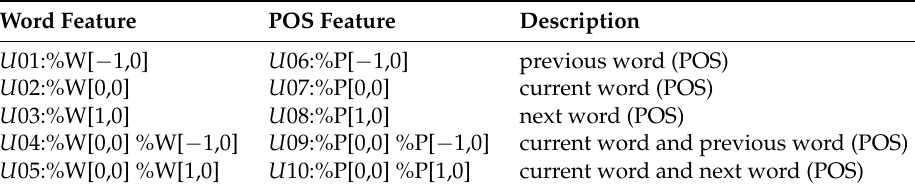
Table 3. Feature templates of the CRF